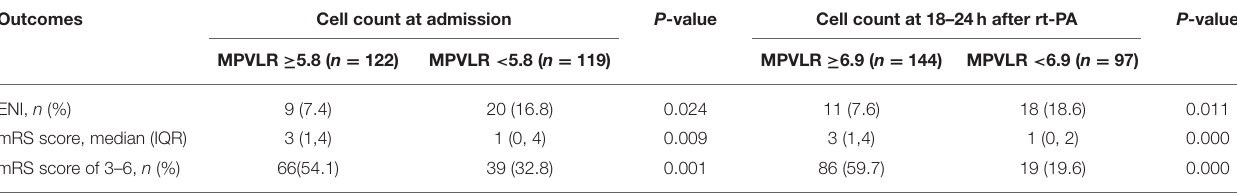
TABLE 4 | Comparison of outcomes between subgroups stratified according to the MPVLR cutoff. Outcomes